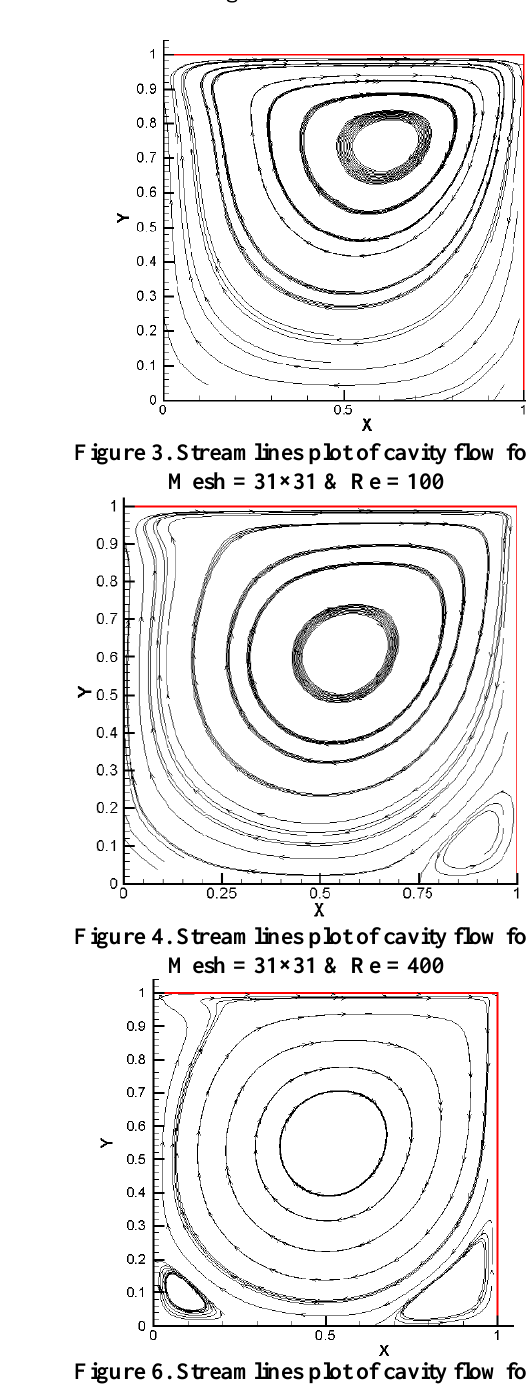
Figure 5. Streamlines plot of cavity flow for Mesh = 31×31 & Re = 1000